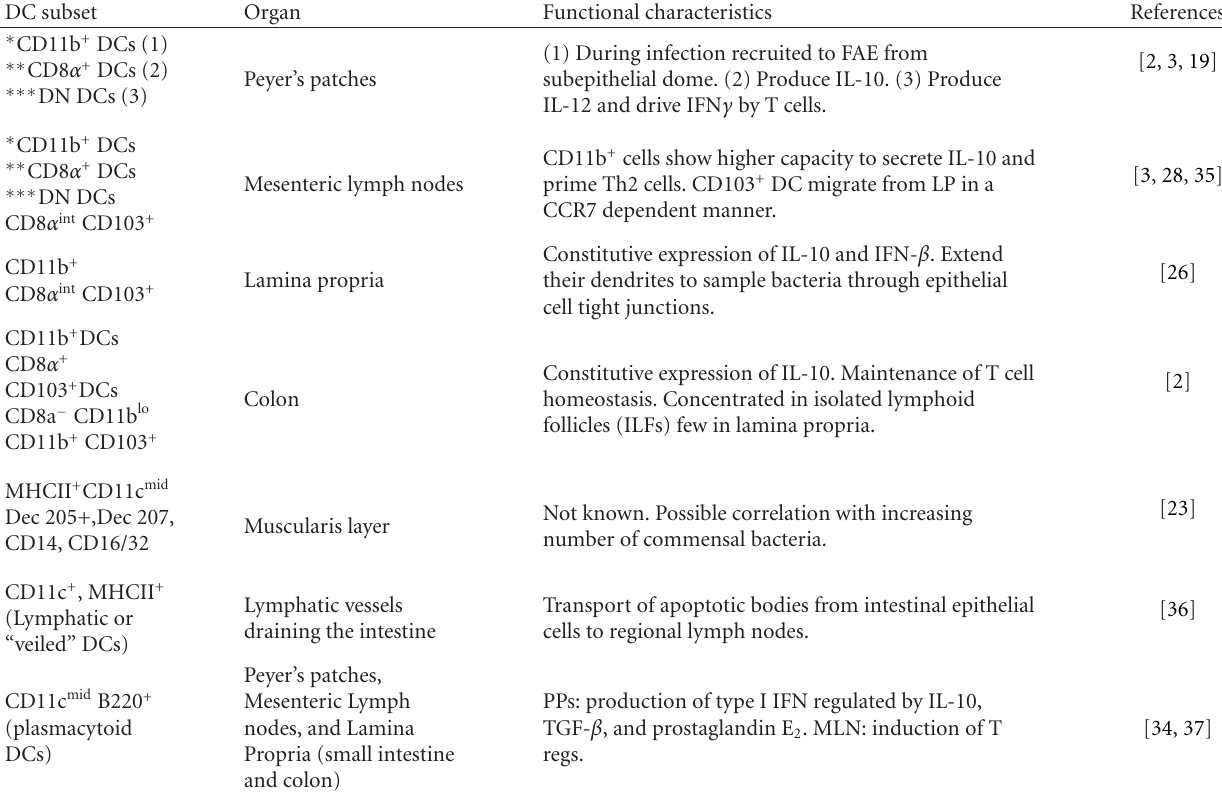
Table 1: Intestinal DC